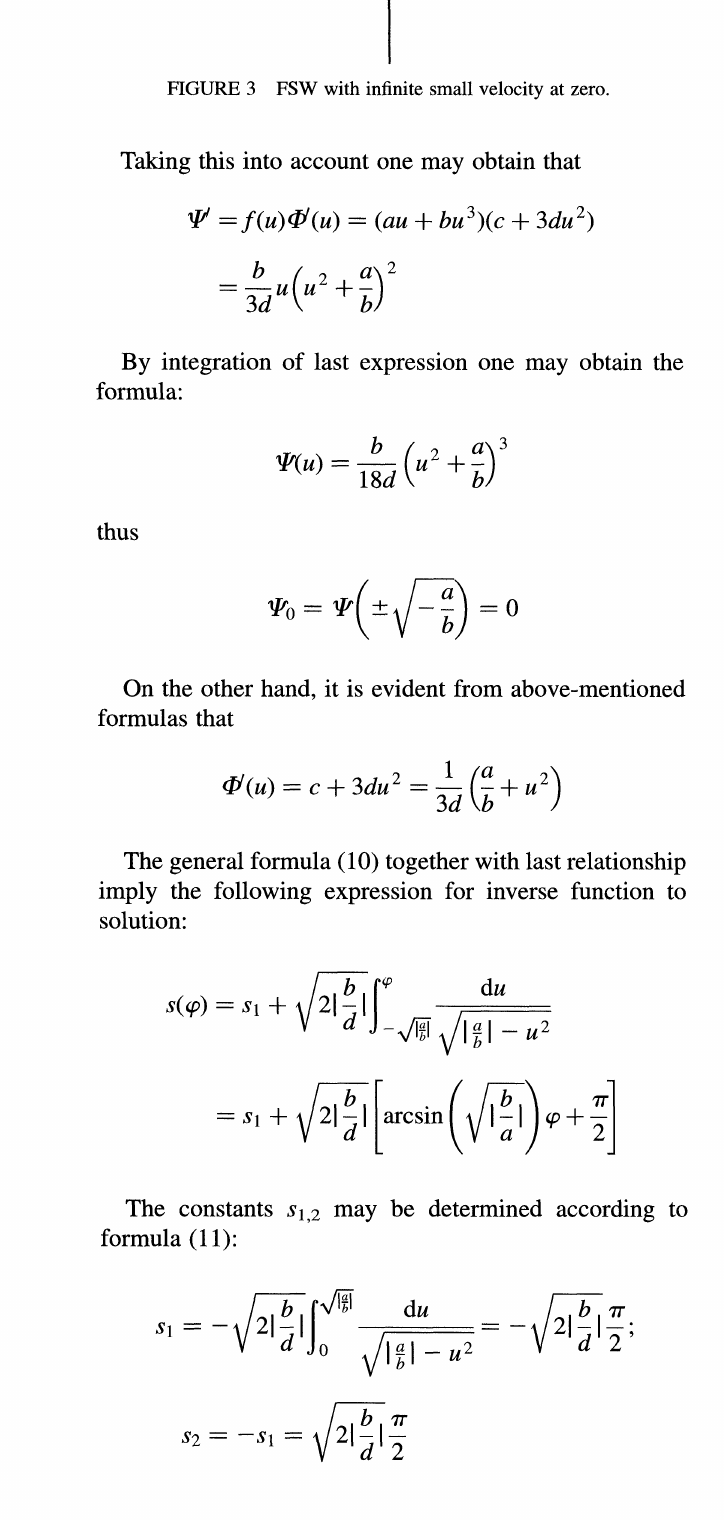
FIGURE 3 FSW with infinite small velocity at